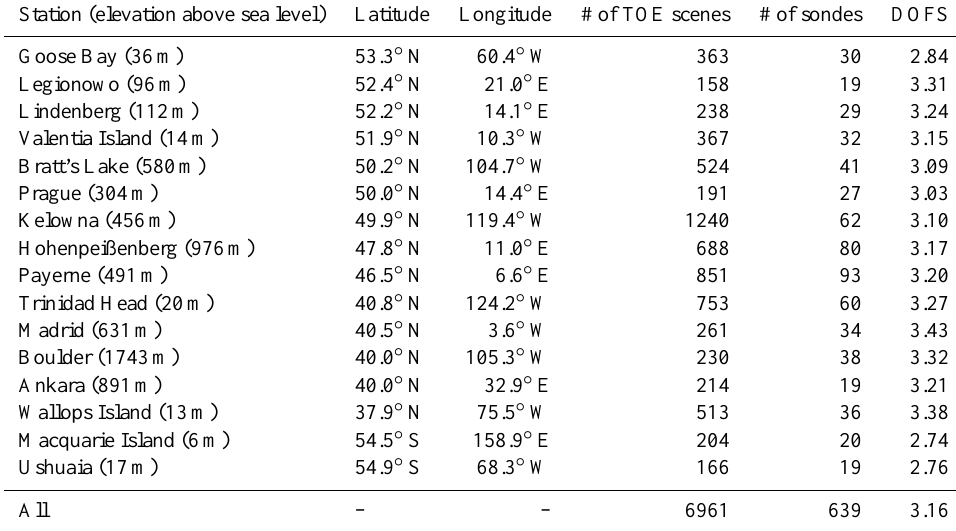
Table 1. Locations with geoinformation and numbers of ozone sondes and IASI-TOE profiles, and mean DOFS. Station (elevation above sea level)